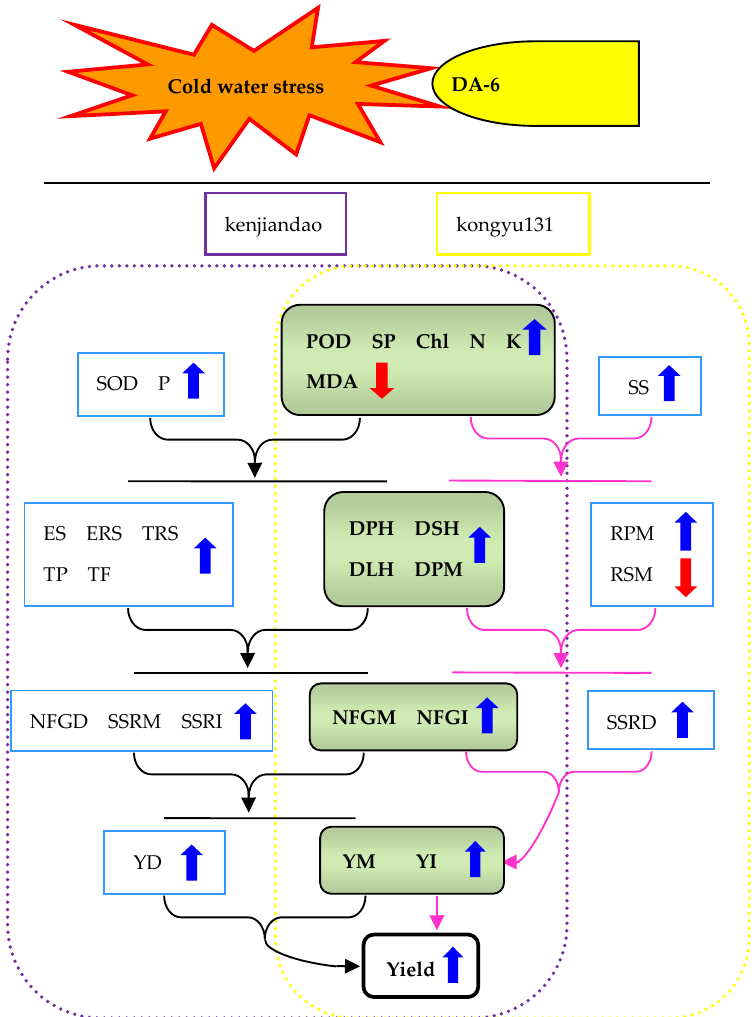
Figure 8. The proposed model of how exogenous diethylaminoethyl hexanoate (DA-6) affects the panicle and leaf response of Kongyu131 and Kenjiandao6 under cold water stress (CWS). The red and blue arrows indicate a decrease and increase, respectively. SOD—superoxide dismutase;